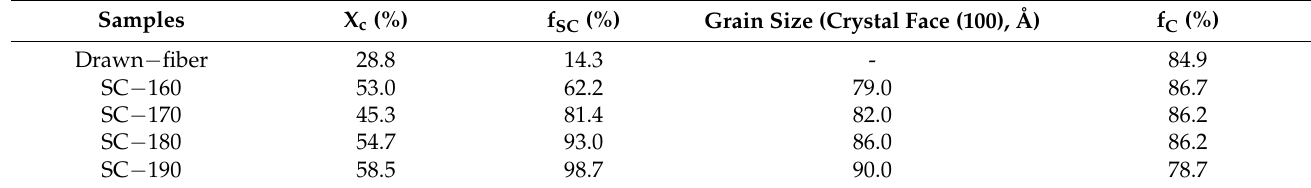
Figure 1. ( a ) WAXD patterns of crystal structure and ( b ) WAXD patterns of crystal orientation. Table 1. Crystallization parameters of drawn − fi ber and SC − PLA fi ber.